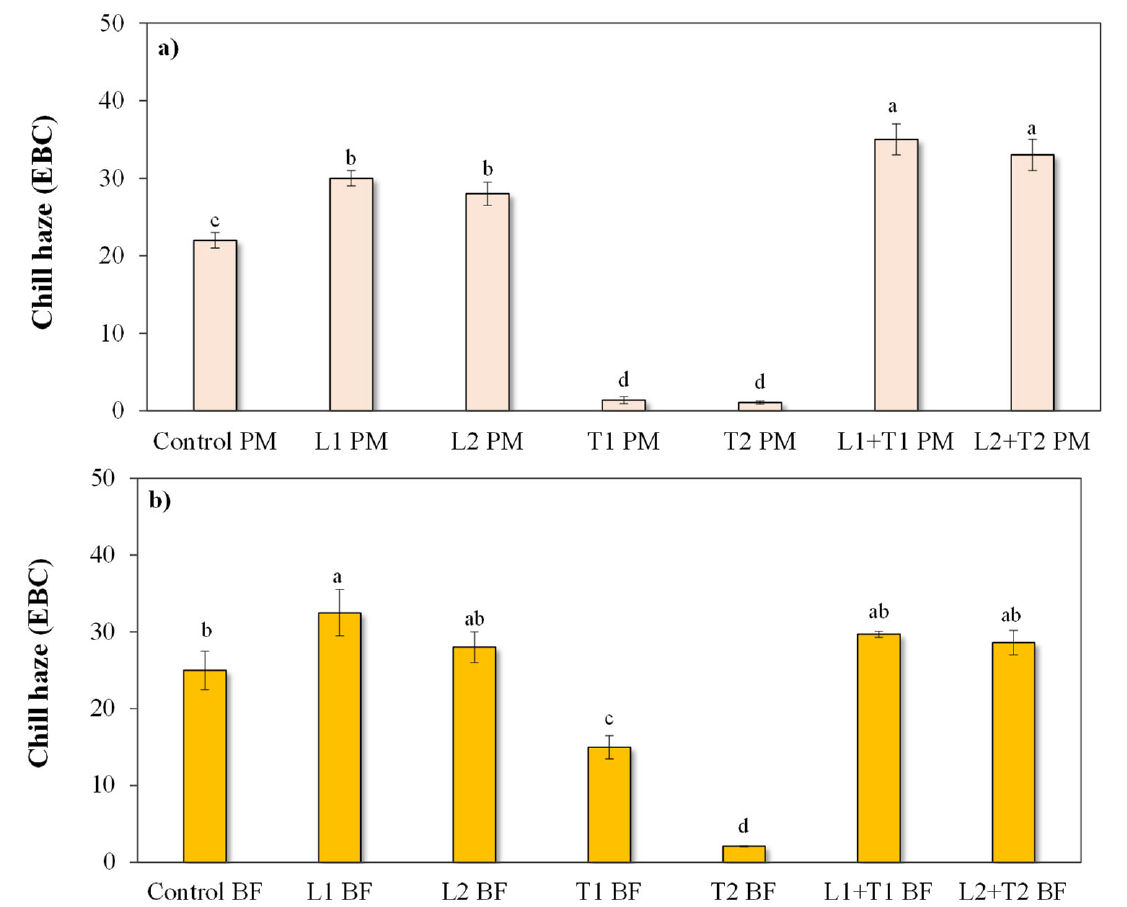
Figure 4. Chill haze (EBC) of enzymatically-treated wort (L: Laccase; T: Tannase) at two different brewing steps: ( a ) post-mashing (PM) and ( b ) after boiling/cooling and before the yeast inoculum for the alcoholic fermentation (BF). Data refer to the chill haze 504 h after the yeast inoculation. Samples were: control (untreated wort), L1 (100 µ L Laccase), L2 (1 mL Laccase), T1 (100 µ L Tannase), T2 (1 mL Tannase), L1 + T1 (100 µ L Laccasi + 100 µ L Tannase), and L2 + T2 (1 mL Laccase + 1 mL Tannase)